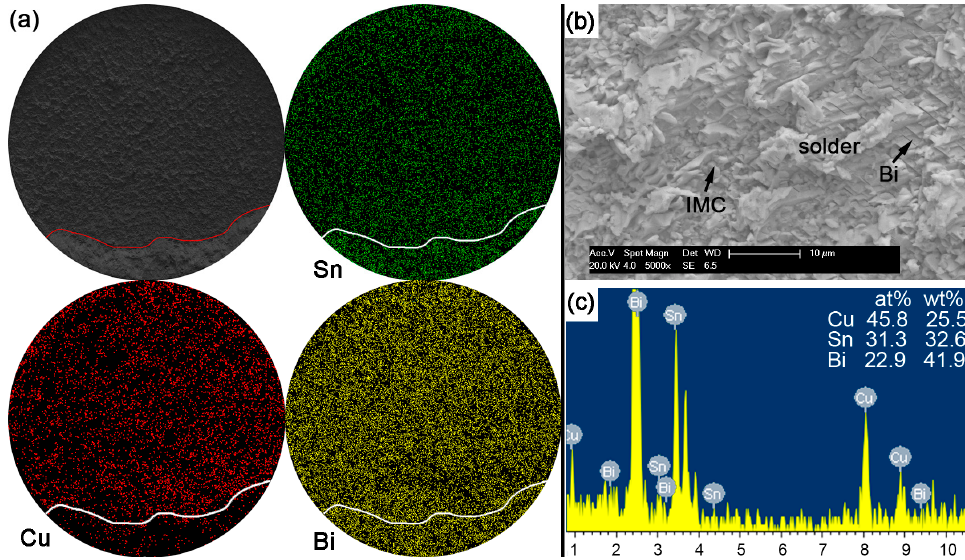
Figure 14. Fracture morphology of as-soldered Sn-45Bi solder bump: ( a ) SEM image and elemental mapping; ( b ) interfacial fracture at higher magnification; and ( c ) EDS analysis on image ( b ).